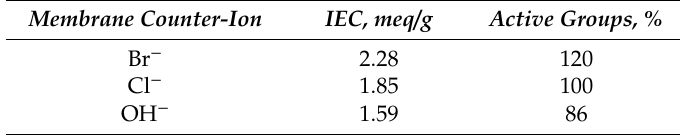
Table 1. Active groups of FAA3-50 membrane with different counter-ions; Br − , Cl − , OH − .